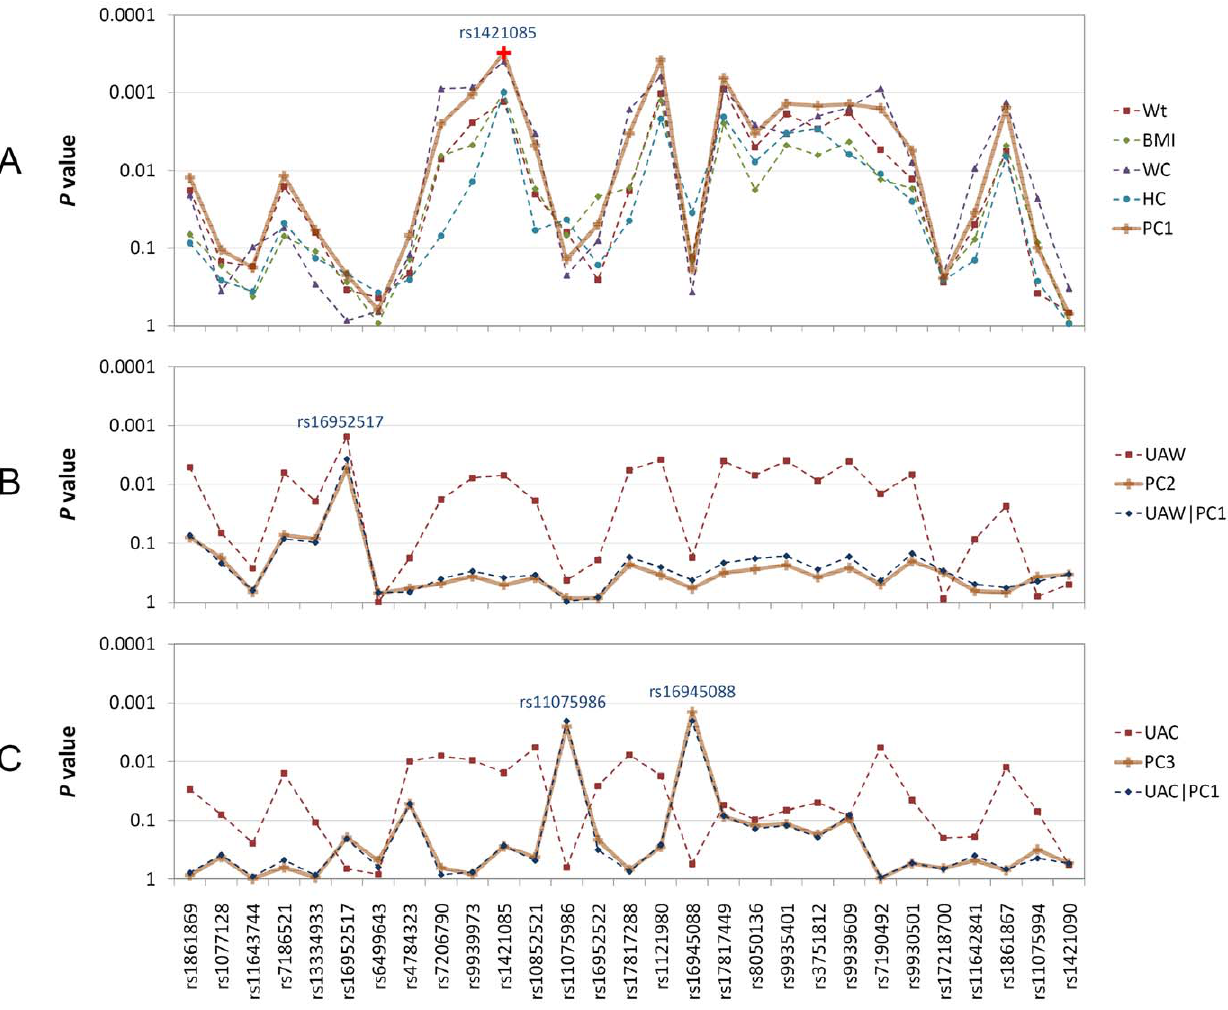
Figure 4. P values of association tests. A) Association test P values between ‘‘body fatness’’ measures (Wt, BMI, WC, HC) and PC1; B) Association test P values of UAW, PC2 and PC1 adjusted UAW (UAW|PC1); C) Association test P values of UAC, PC3 and PC1 adjusted UAC (UAC|PC1).